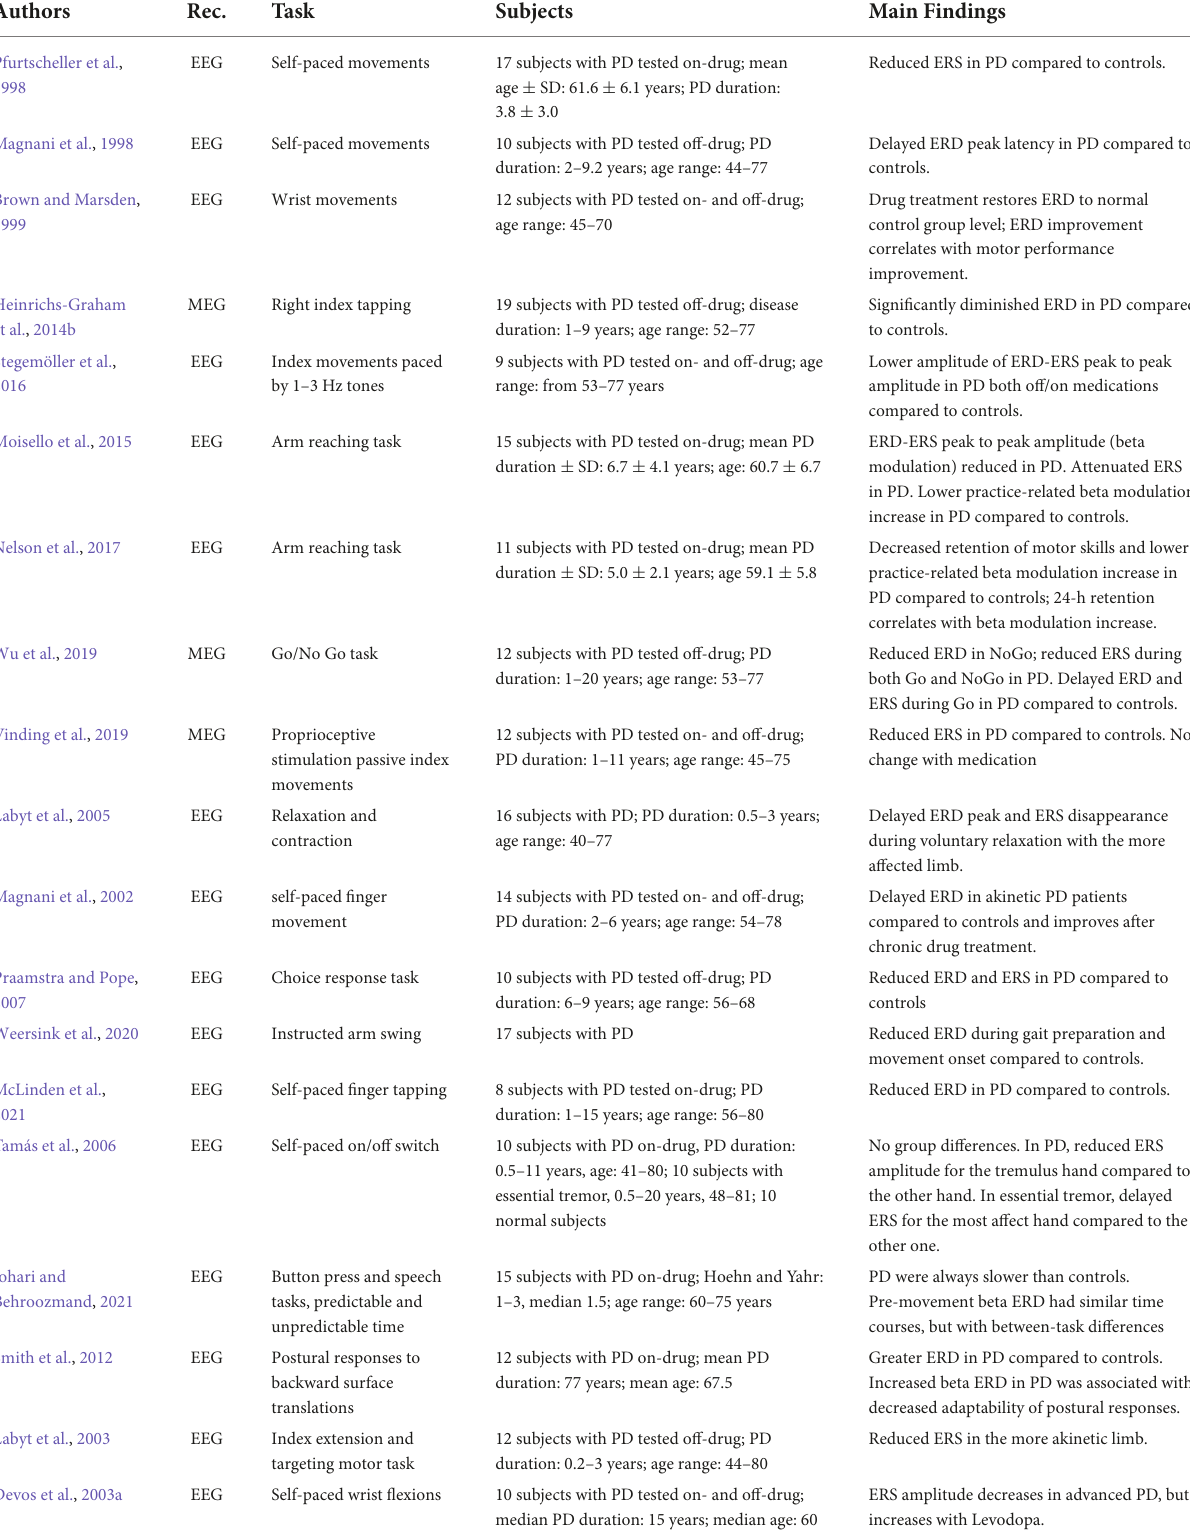
TABLE 2 Review of studies on movement-related beta ERD and ERS over cortical and subcortical structures in Parkinson’s disease with EEG, MEG, cortical (ECoG) and subcortical (STN DBS)